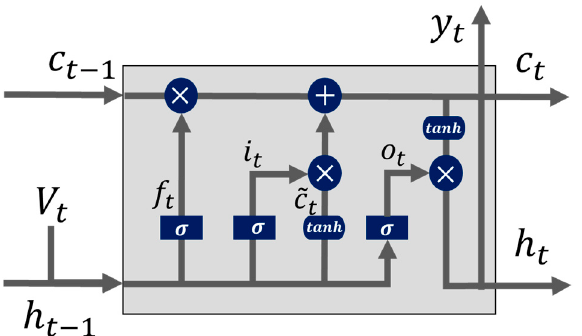
Figure 2. The structure of the LSTM model [34] .